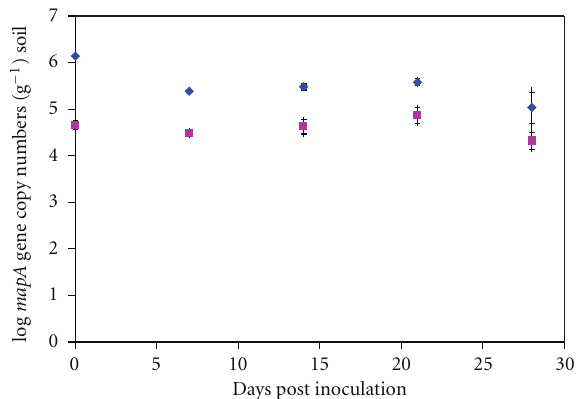
Figure 2: Detection of C. jejuni mapA gene copies in soil from experiment A throughout the sampling period of 28 days, with starting inoculation doses of 10 6 and 10 7 C. jejuni cells, corresponding to 10 5 (blue diamonds) and 10 6 (pink squares) cells g − 1 soil. Error bars represent standard deviations from 5 replicate samples and 3 di ff erent real-time PCR reactions per replicate.